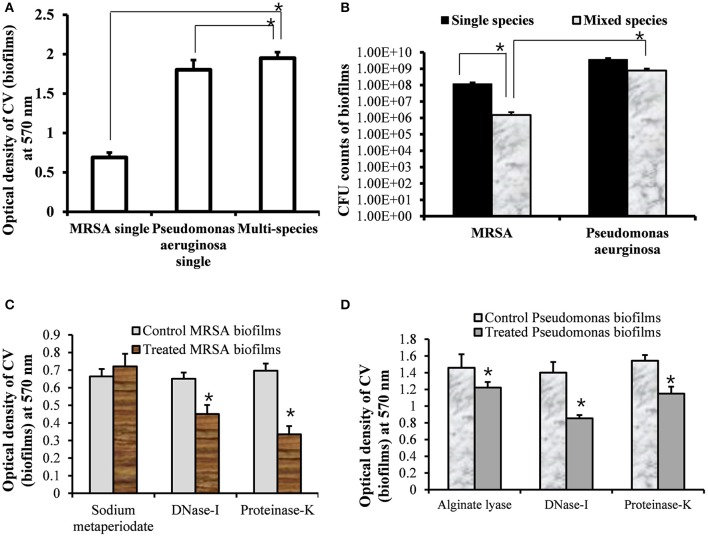
Quantification of single- and multi-species in vitro biofilms of methicillin-resistant Staphylococcus aureus (MRSA) and Pseudomonas aeruginosa (PA). (A) Quantification of single-species and multi-species biofilms of MRSA or PA using crystal violet microtiter plate assays. (B) Colony forming unit (CFU) counts of bacteria within single- and multi-species biofilms of MRSA or PA. (C) Eradication of pre-established MRSA biofilms with sodium metaperiodate (SM), DNase I and proteinase K with respect to control (untreated). (D) Eradication of PA pre-established biofilms with alginate lyase, DNase I, and proteinase K. The error bars represent the standard deviation from the mean value. The results were compared using a Student's t-test (*p < 0.05).